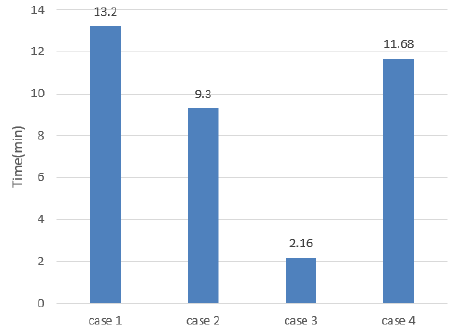
Fig. 6. The workflow of event-based data processing. Fig. 6. The performance evaluation of